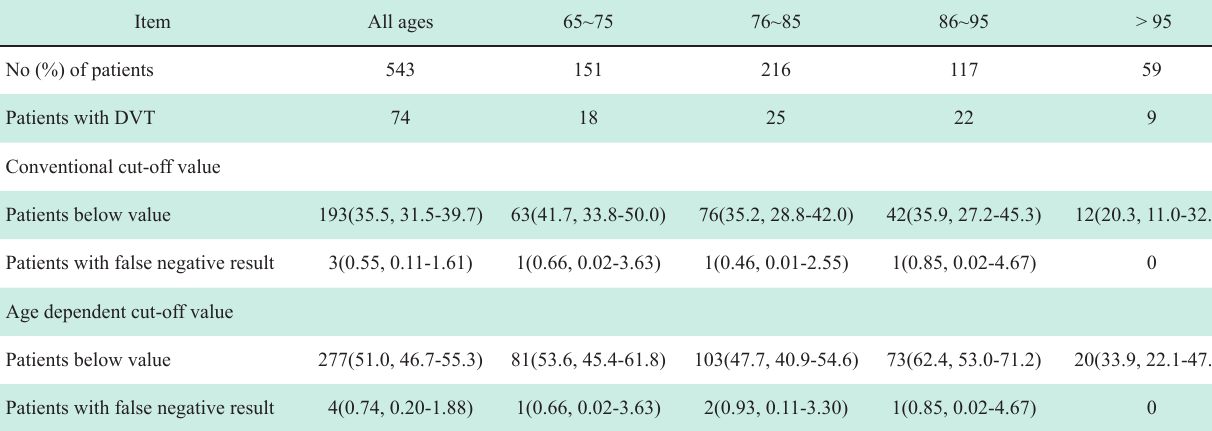
Table 4 Proportion of patients with unlikely probability of DVT according to